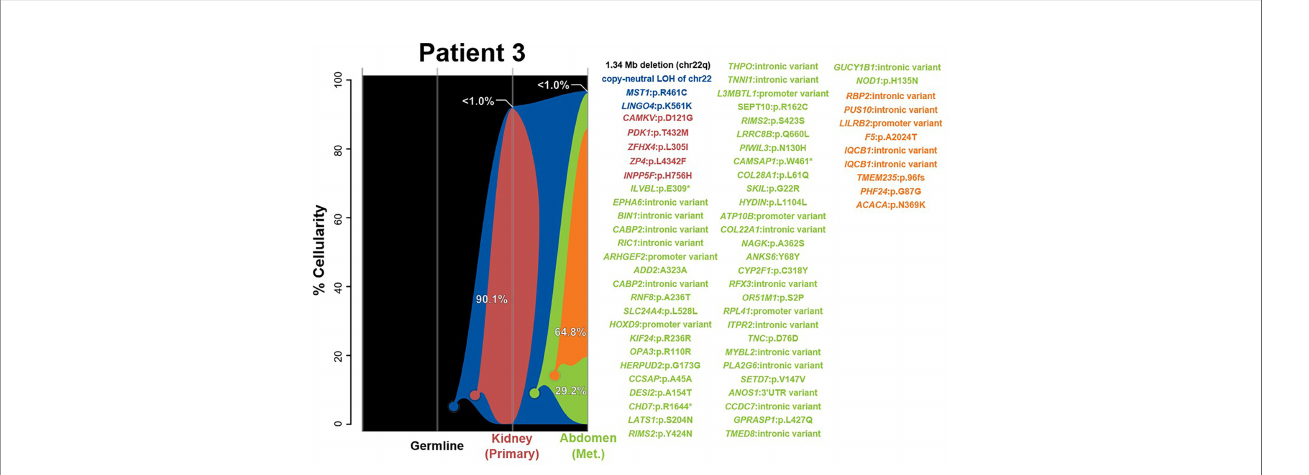
FIGURE 3 | River plots show the composition of clones in multiple tumor samples plus matched normal blood (germline) sample. Vertical lines indicate a sample, labeled on the X-axis. Colored circles indicate the origins of a clone from a single cell, either of the germline (black) or a preceding clone. Colored outlines show the cellularity of clones (Y-axis) in each sample. Percentages shown (in white or black text) indicate the cellularity of a tumor clone in each sample that was identi fi ed, excluding the cells of any descendant clones. Clone percentages sum to the total tumor cellularity of a sample. Samples are arranged to most clearly visualize clonal descent but do not represent a formal time-series. Copy number variants (CNVs), loss-of-heterozygosity events (LOH), and single nucleotide variants (SNVs) identi fi ed in the tumor samples, as well as relevant germline predisposition variants, are listed on the right and colored by which clone they belong